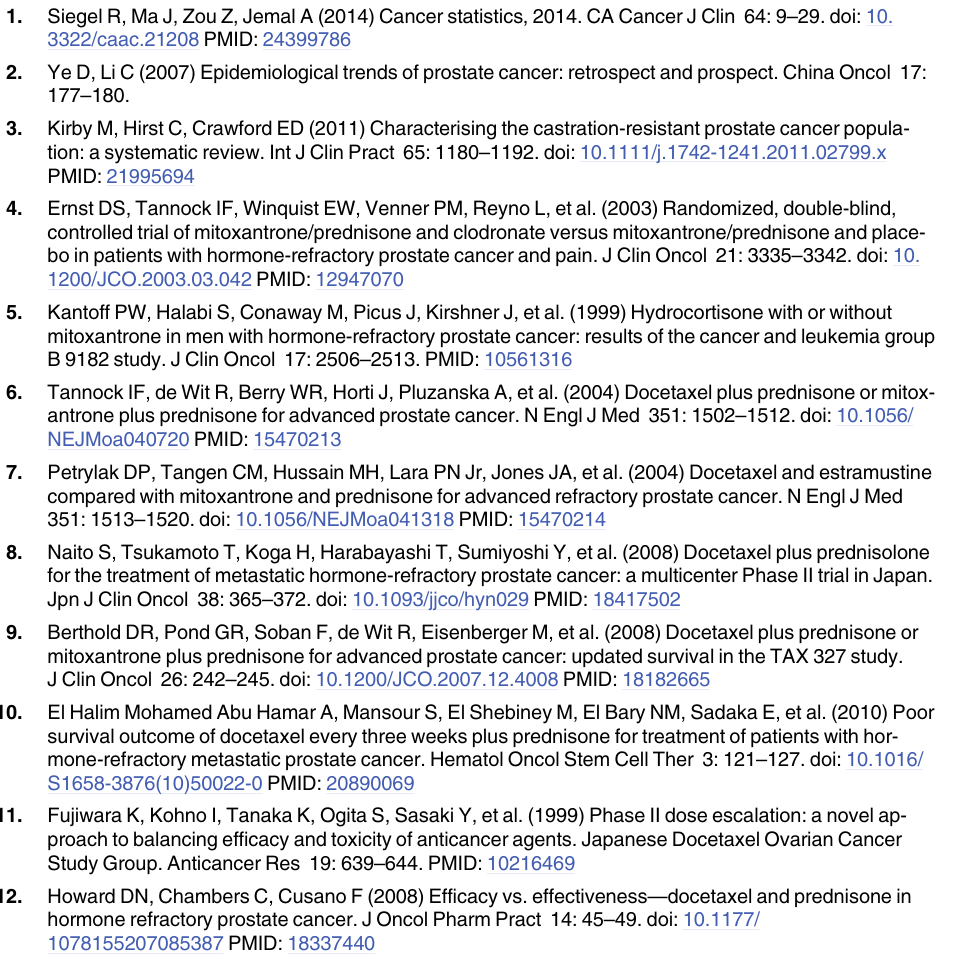
S1 Table. Definition and criteria for efficacy assessments. S2 Table. Definition and criteria for hematologic